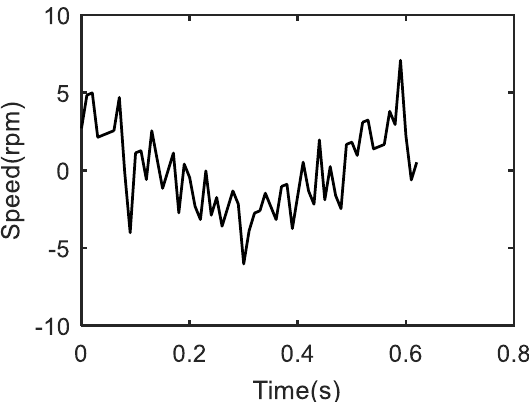
Figure 10. Fitting error of AMT input shaft’s speed curve without TB action.